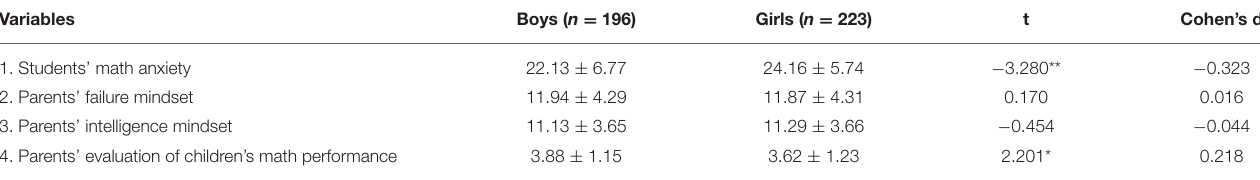
TABLE 1 | Descriptive statistics of variables on gender. Variables